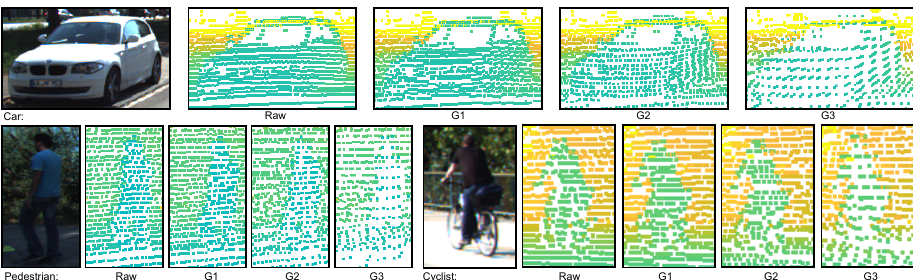
Figure 1. Examples of point cloud representations for each of the three classes of objects in the KITTI dataset. From left to right in each image we can see the RGB image, a representation of the raw point cloud, and point cloud representations at compression degrees G1, G2 and G3.